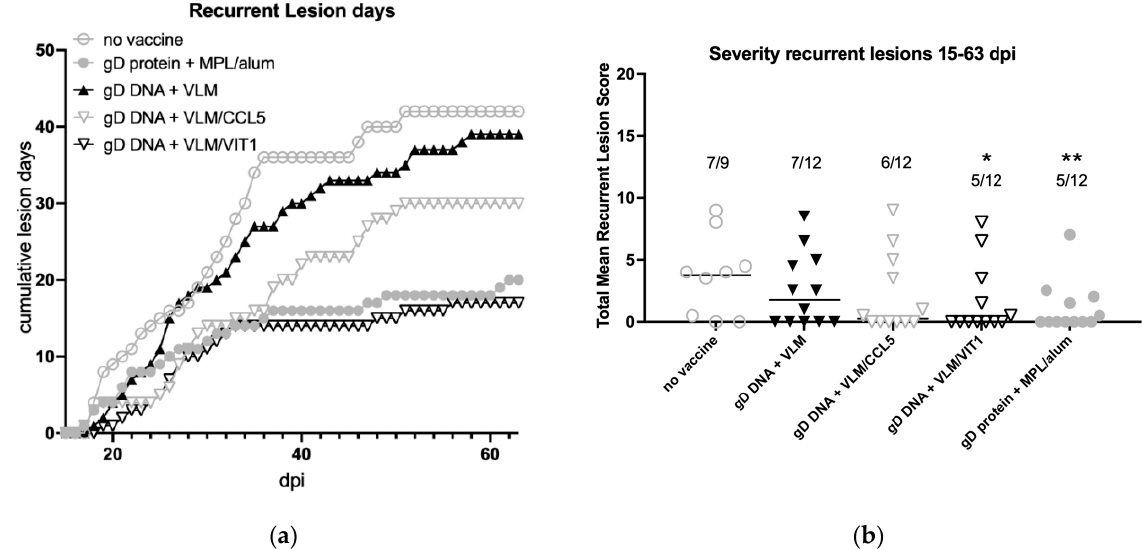
Figure 6. Immunisation with VLM and VIT protects against recurrent disease from day 21–63 following intravaginal challenge with HSV-2. The effect of immunisation on recurrent disease ( a ) and disease severity ( b ) were examined days 15–63 post intravaginal challenge with HSV-2 strain MS. The animals were evaluated daily for presence of recurrent lesions and scored. Comparisons of disease severity are shown in b with means and standard deviation indicated with pairwise comparisons to no vaccine analysed by Wilcoxon test, p < 0.05 (*) and < 0.01